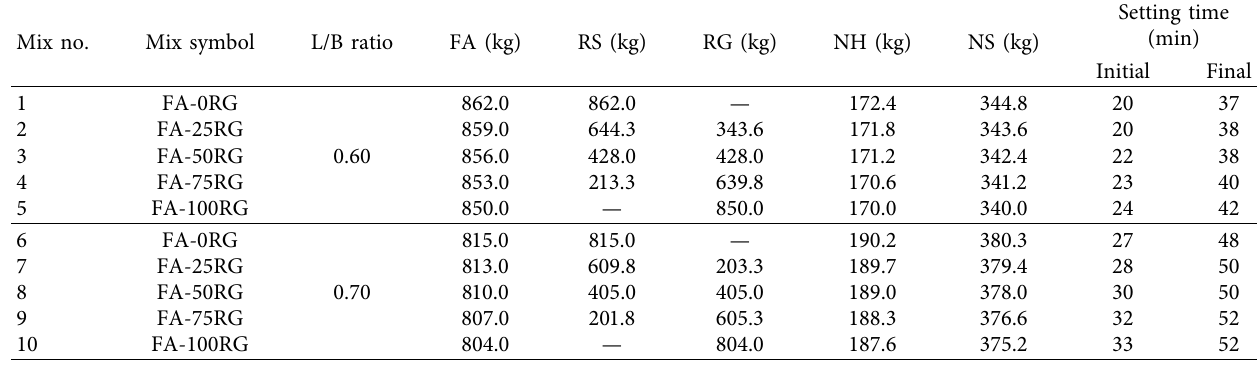
Table 2: Mix proportions of alkali-activated high-calcium FA mortars with RG (kg/m 3 ). Mix no.